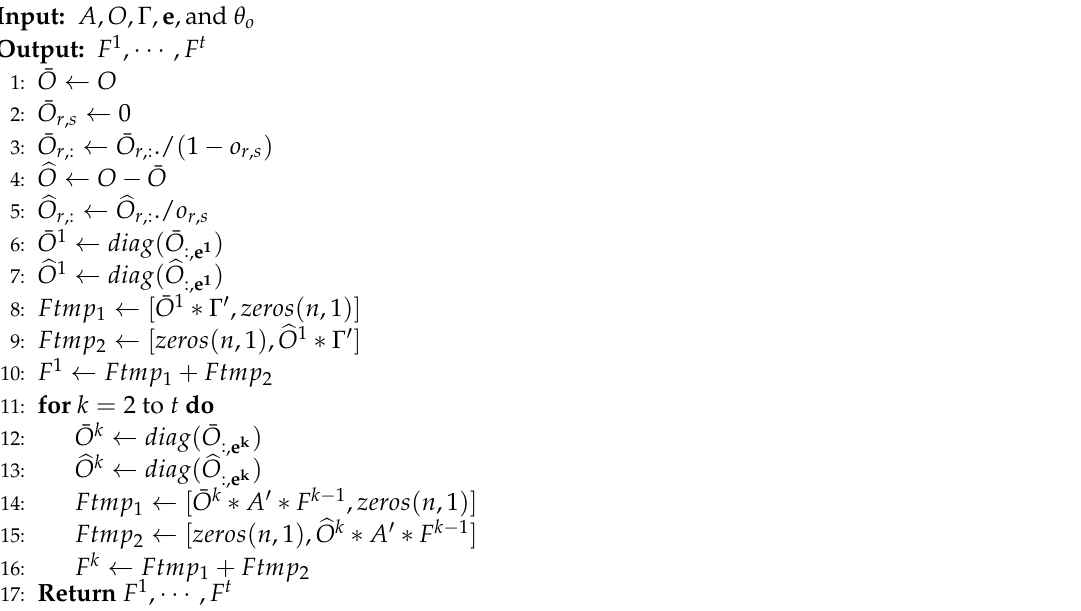
Algorithm 3 This computes the coefficients of the forward (filtering) probability sensitivity